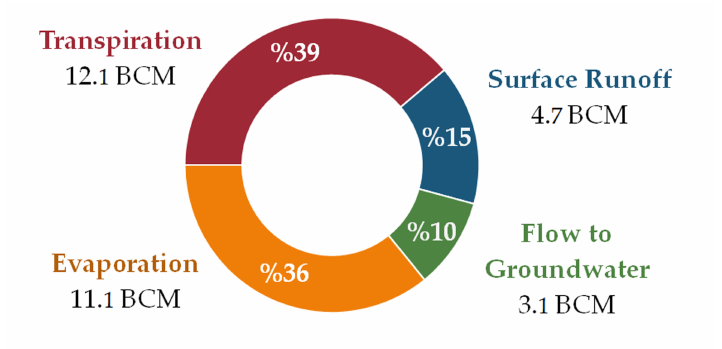
Figure 11. Estimated average water budget components of the Sakarya River Basin.